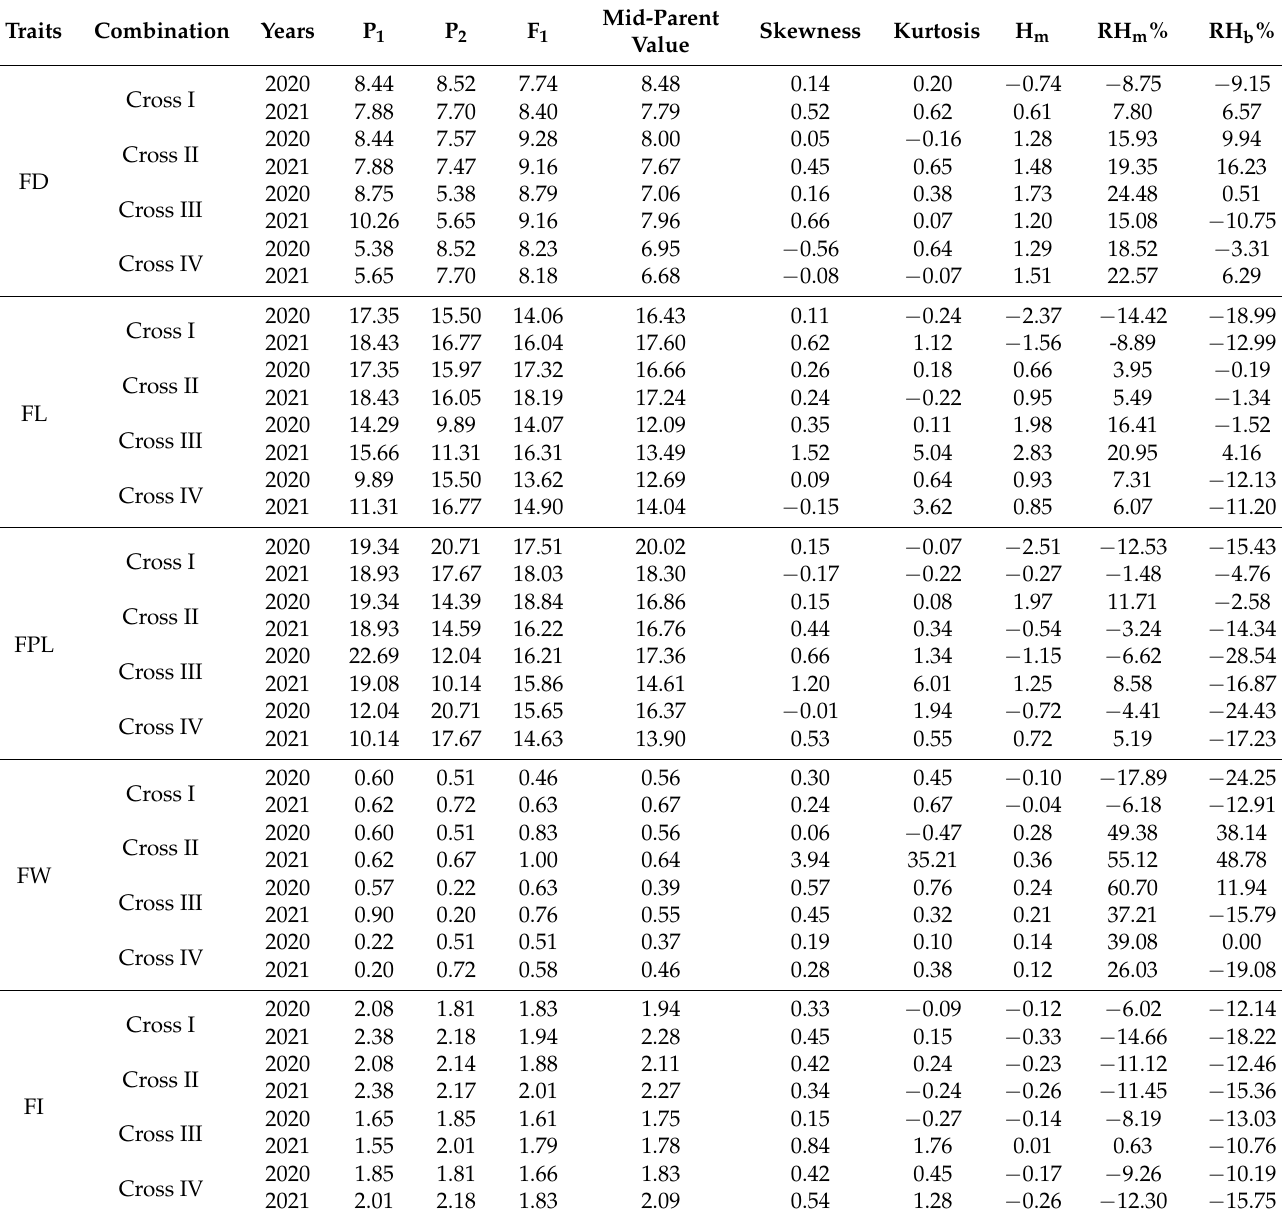
Table 4. Heterosis of five fruit traits in F 1 hybrids from four